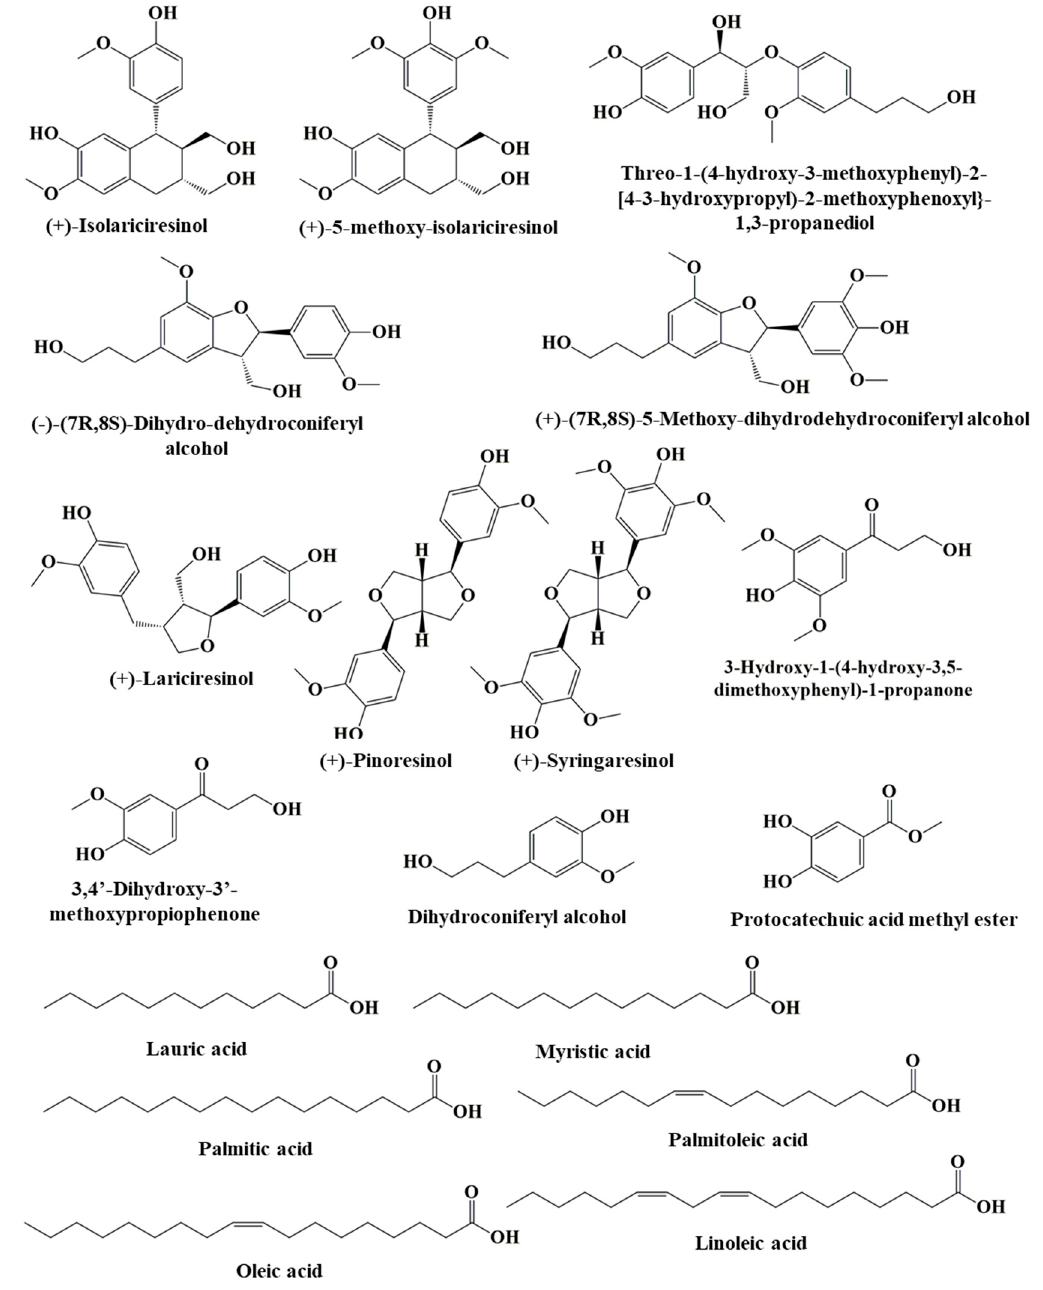
Figure 5. Major lignans and fatty acids present in açaí fruit seeds and pulp.